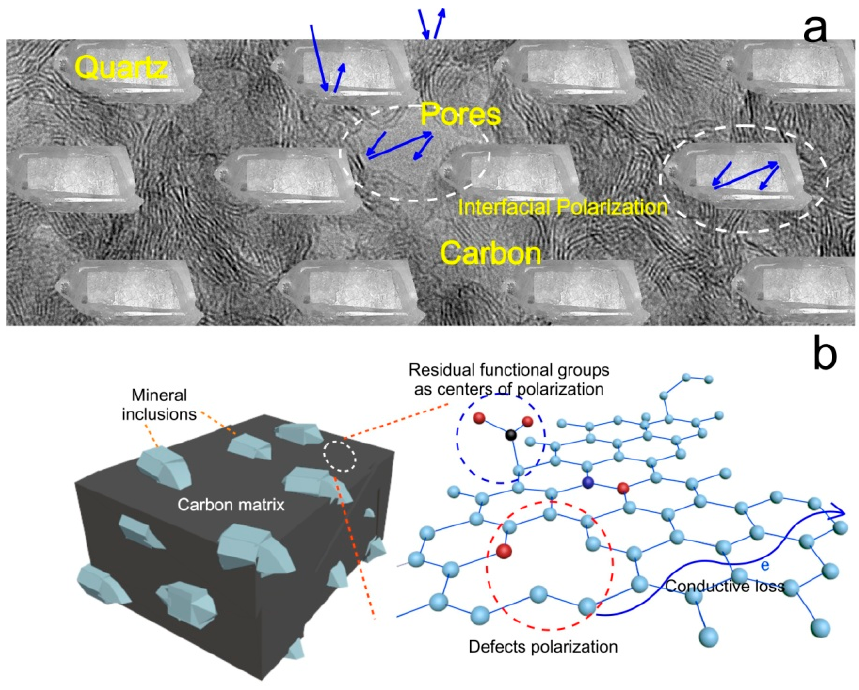
Figure 17. Main mechanisms of shielding electromagnetic radiation in a mixed carbon–mineral com- posite (( a ), from [81]) and shungite carbon ( b ). Blue arrows show direction of microwave radiation